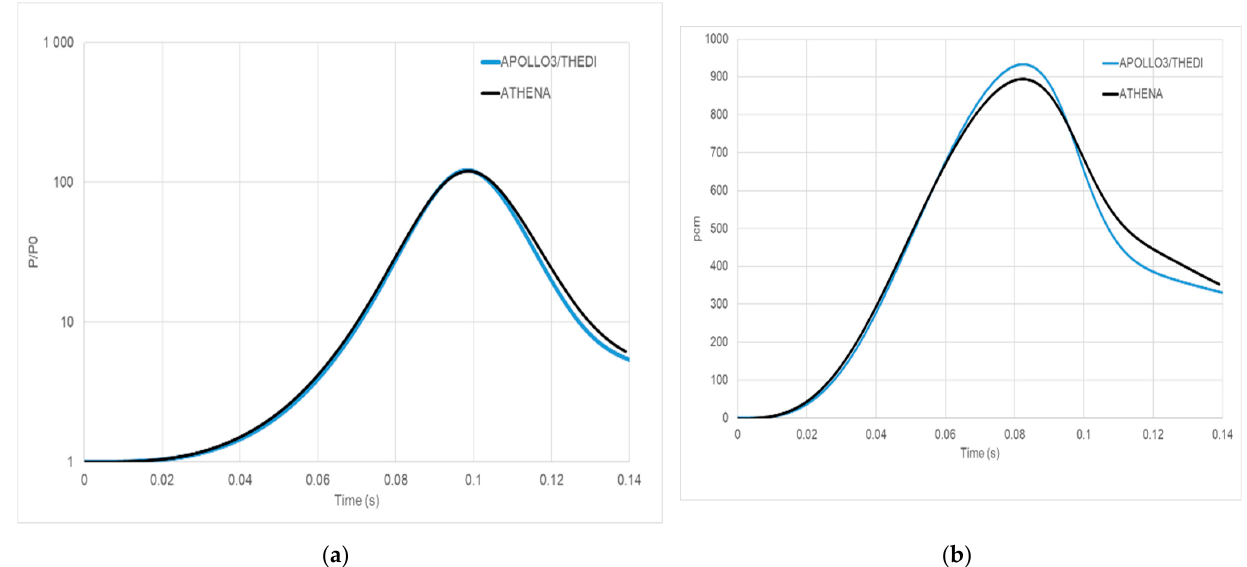
( b ) Figure 14. Pairs plot (PU_CONTENT/ENRI, DMOD): ( a ) PWR UOX CELL; ( b ) PWR MOX CELL. HEXAGONAL UOX CELL The Hexagonal UOX Cell case was also treated. Figure 15 shows that also, in this case, an expected linear dependence of the k ∞ with respect to the cell-pitch variation (due to the fuel-to-moderato ratio) is observed for the PWR UOX case (Figure 11). The effect of reactivity reduction related to the boron concentration increase is also indicated in Figure